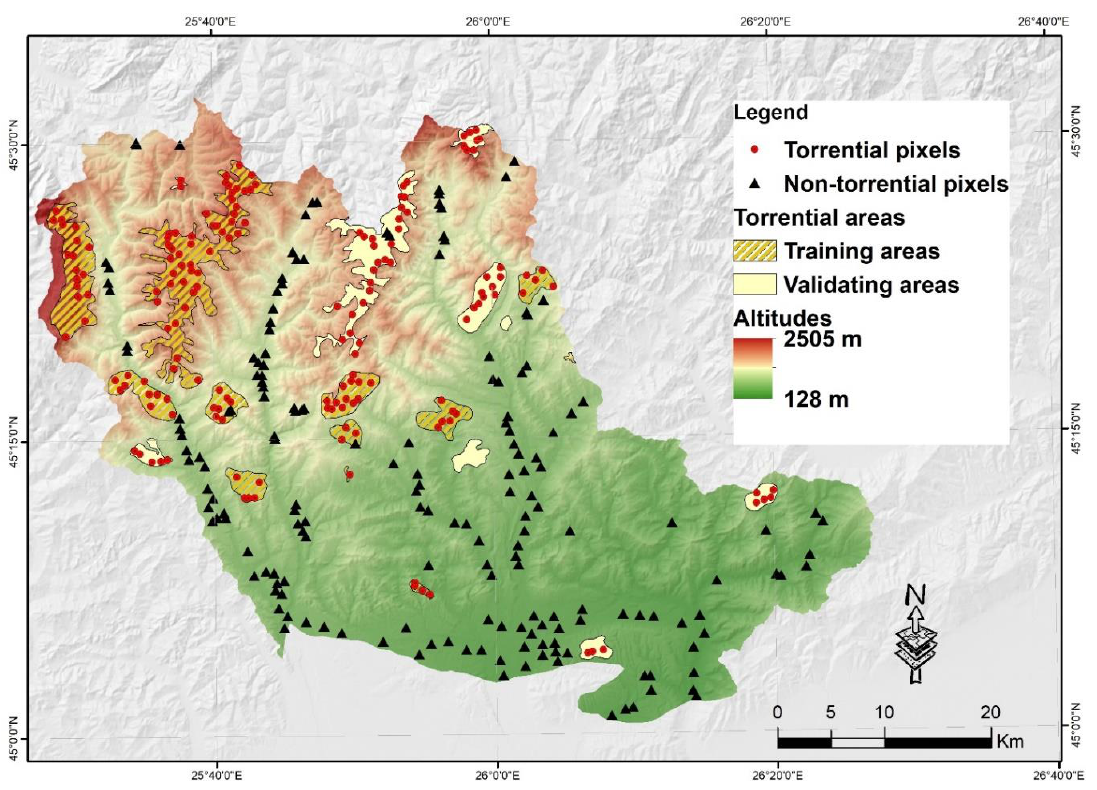
Figure 3. Spatial distribution of torrential areas within the study area (70%—training areas; 30%— validating